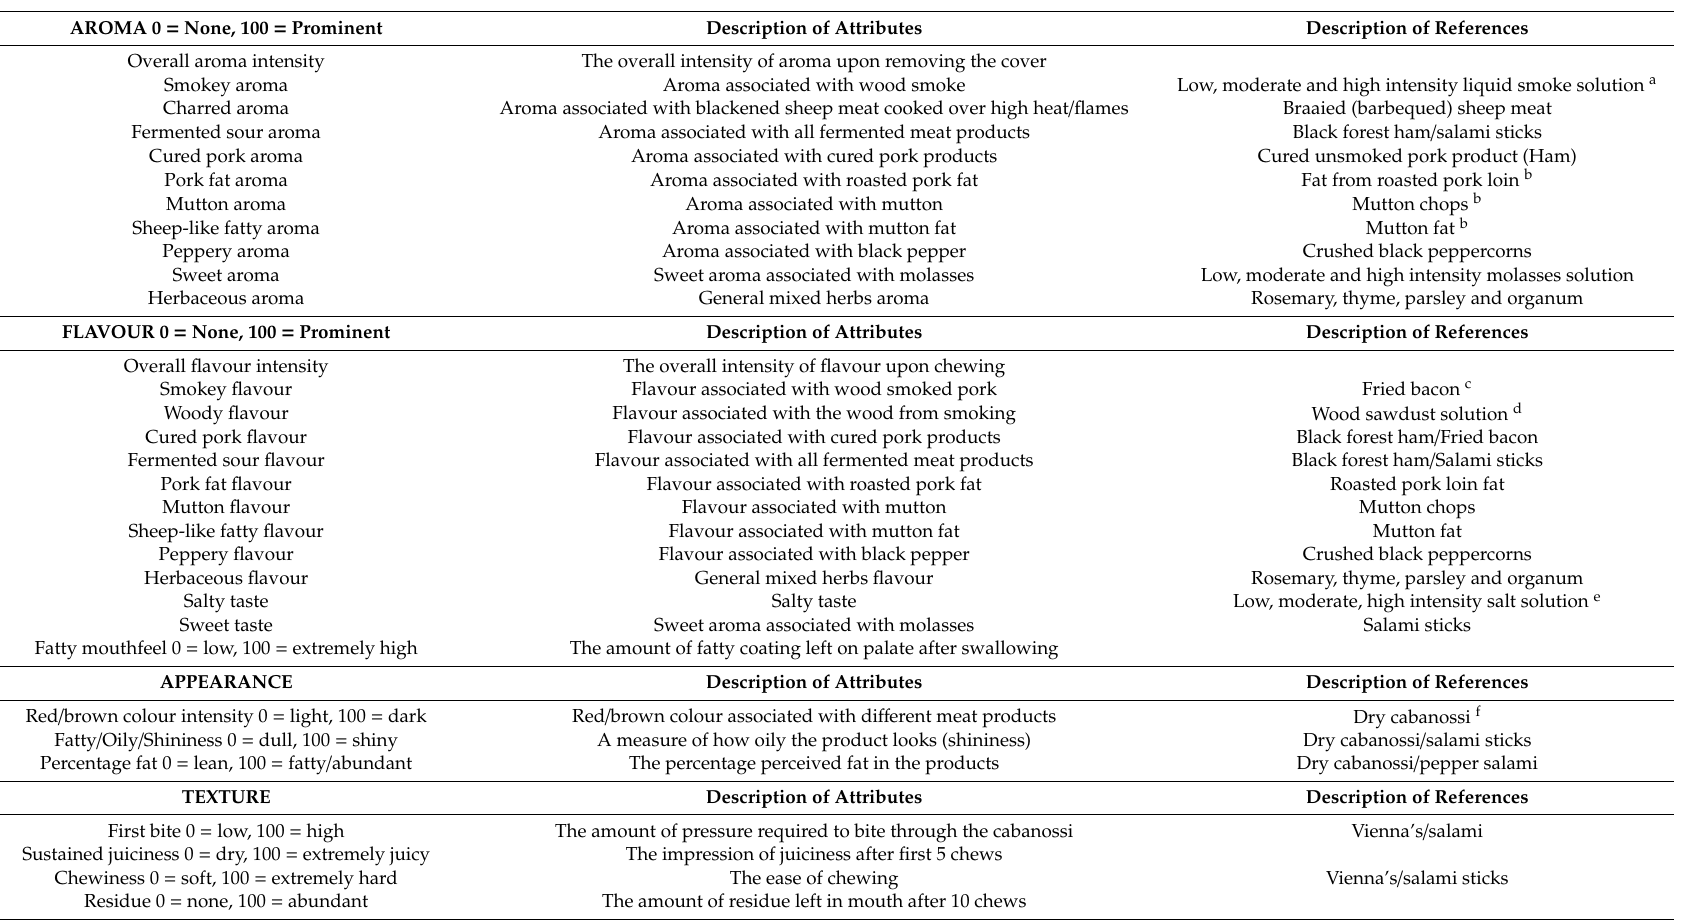
Table 1. Sensory attributes description, scale and reference standards used for the descriptive sensory analysis of two cabanossi